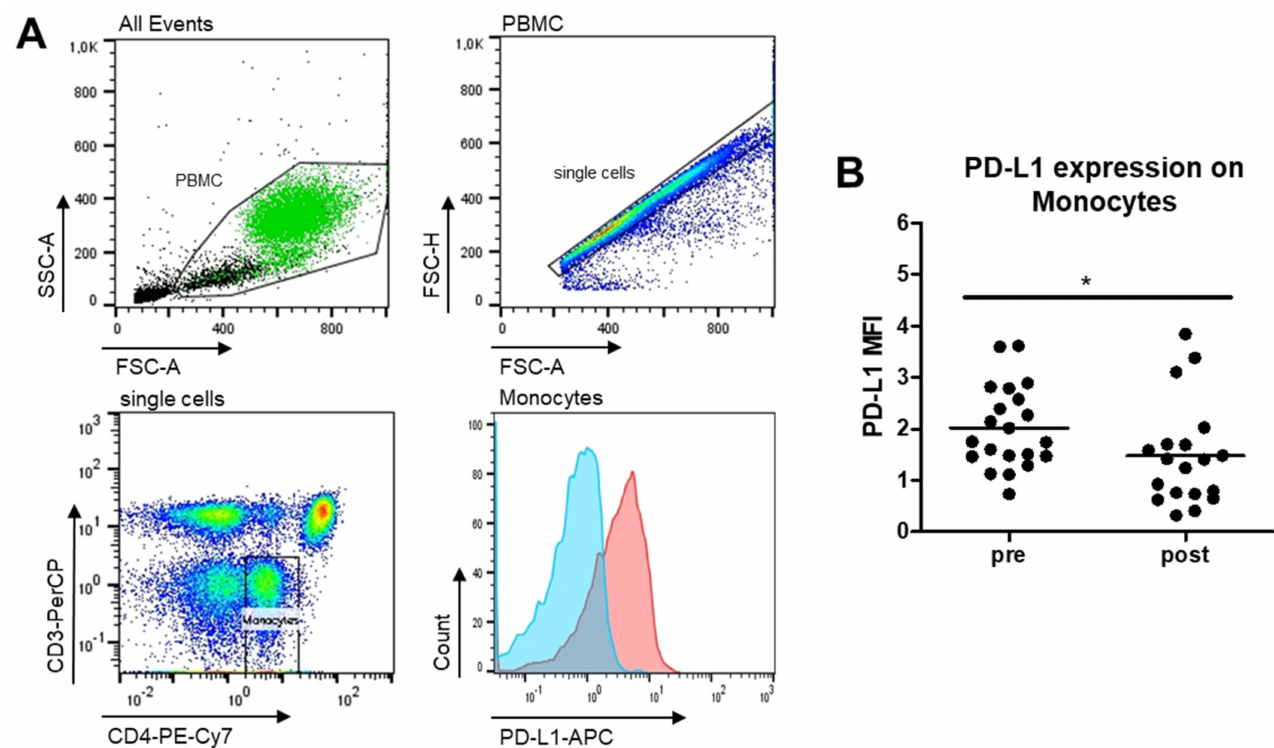
Figure 2. Flow cytometric analysis of monocytes in PBMC from OSA patients before and after PAP treatment. ( A ): Gating scheme of monocytes (green) within the PBMC fraction. Gating was performed by the help of low CD4 expression of monocytes, lack of CD3 and their FSC/SSC characteristics. Histogram shows expression profile of one representative patient before (red peak) and after (blue peak) therapy. ( B ): PD-L1 expression intensity (MFI) on total monocytes measured as CD4 low+ CD3 − cells in isolated PBMCs. n = 25. *: p <